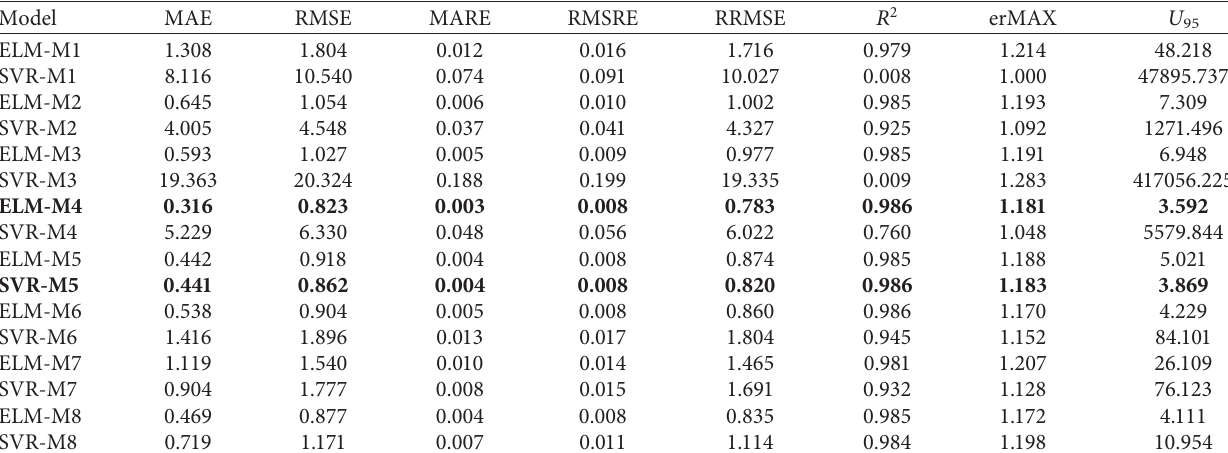
Table 5: Statistical indicators of each predicted models for USGS 14181500 station during the testing phase. Model